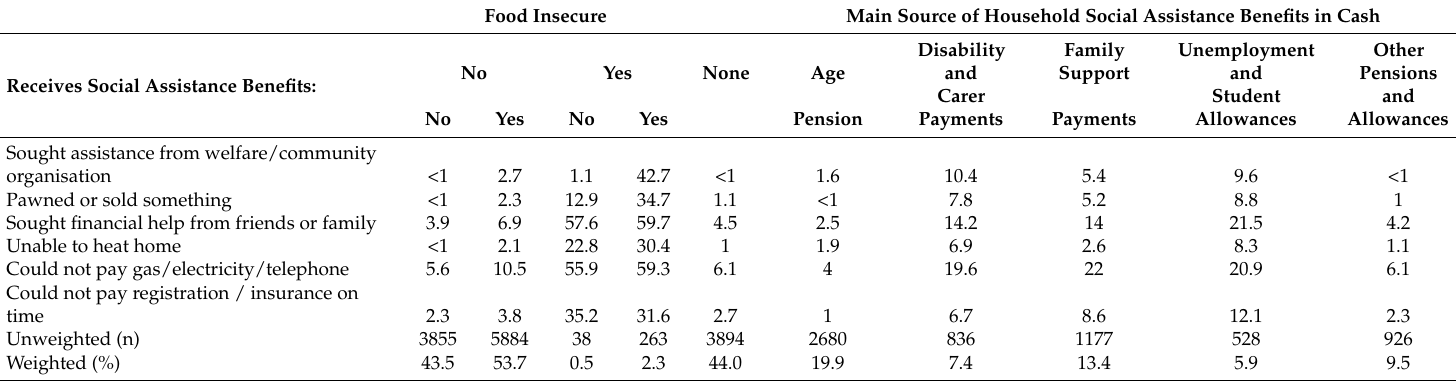
Table A1. Indicators of Financial Stress (%) by Food Insecurity Status and Receipt of Social Assistance, Households 2015/2016. Food Insecure Main Source of Household Social Assistance Benefits in Cash Disability Age and Receives Social Assistance Benefits: